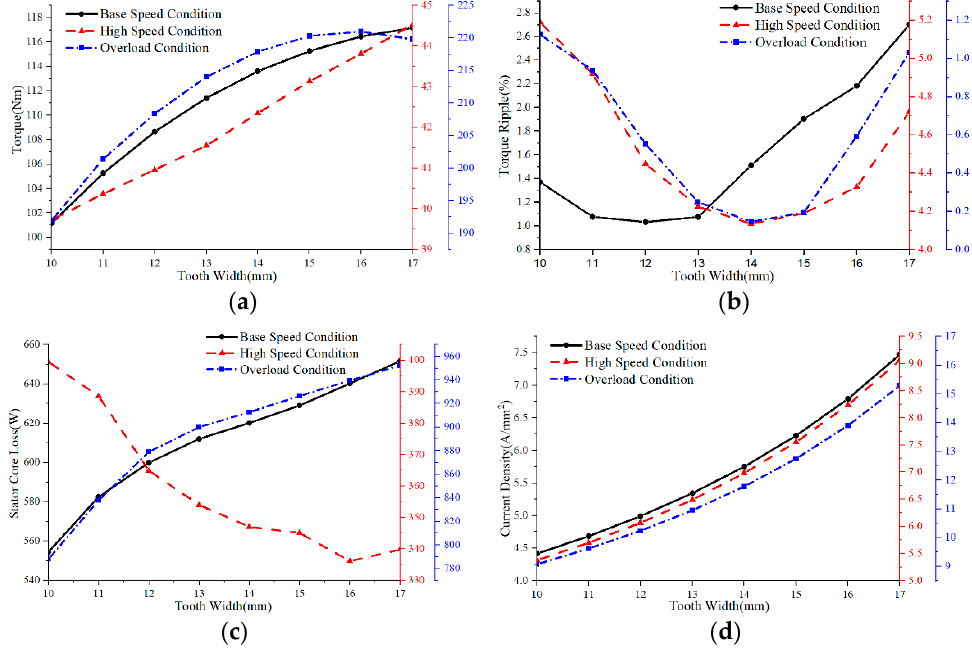
Figure 14. Electromagnetic characteristics vary with different tooth width: ( a ) output torque, ( b ) torque ripple, ( c ) stator core loss, ( d ) current density.